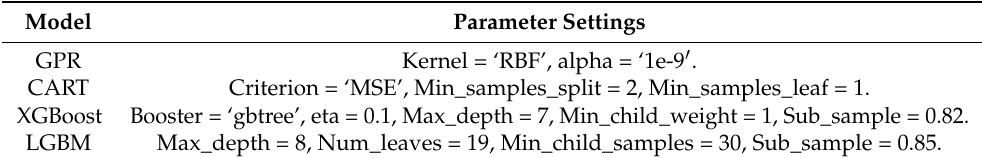
Table 1. Parameter setting of healthy